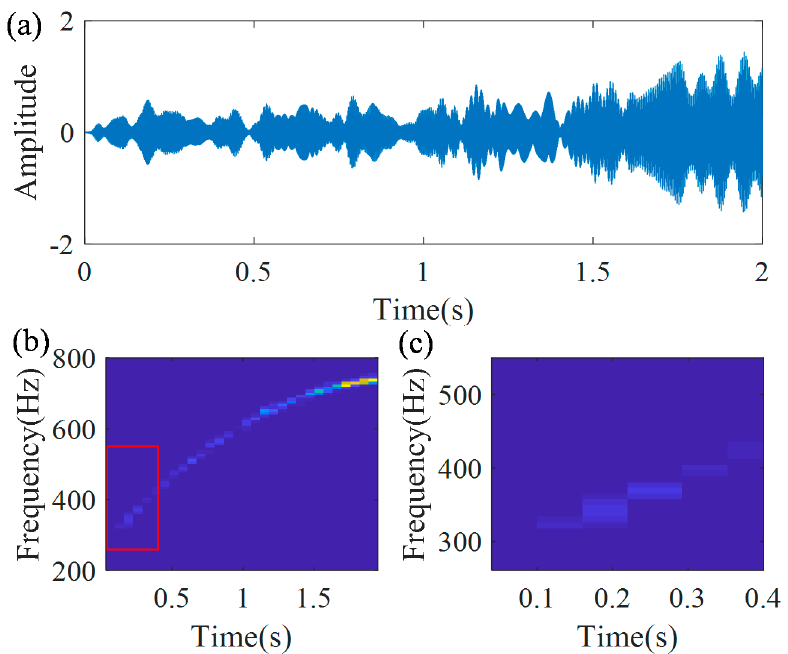
Figure 8. Separated frequency component: ( a ) separated signal; ( b ) TFR; and ( c ) local zoom.